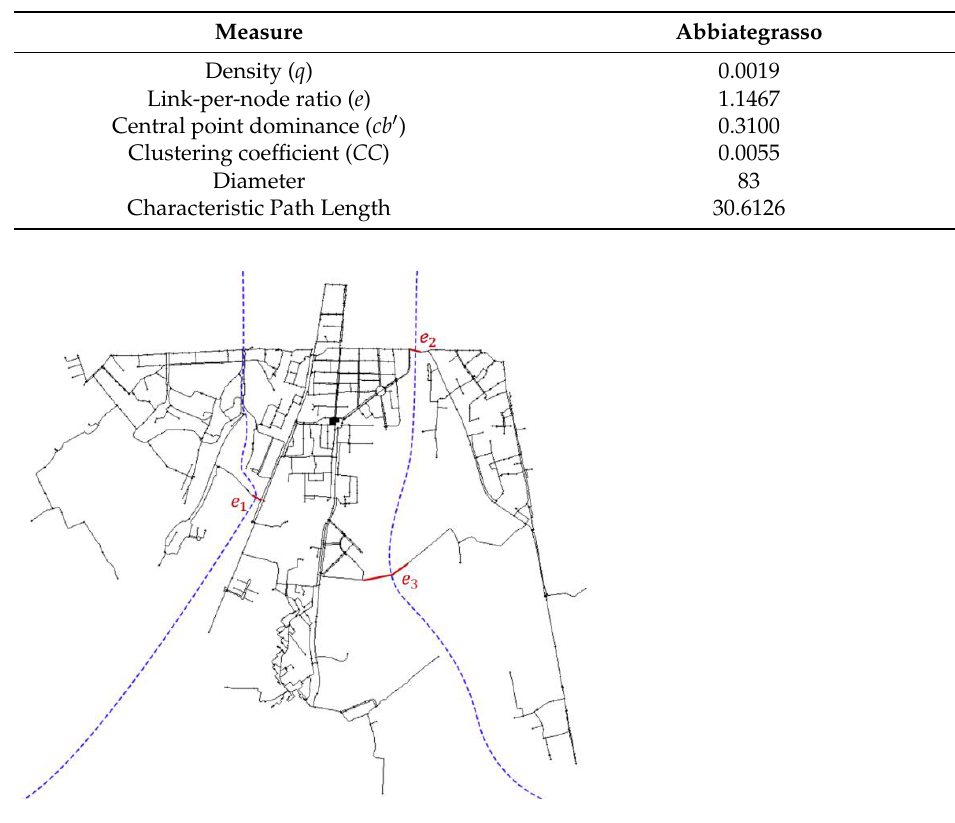
Figure 4. Critical edges (red) highlight a cut-set in Abbiategrasso consisting of 3 edges (bridges) whose simultaneous removal generates a disconnection.